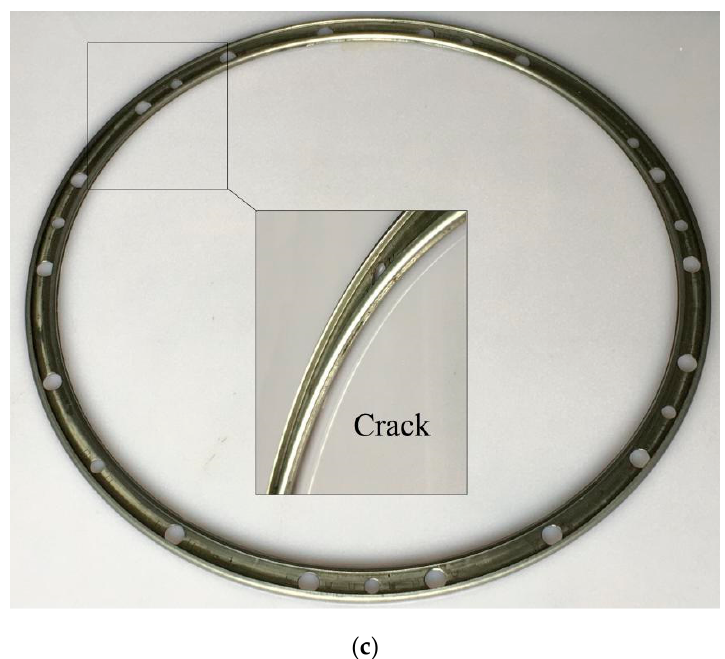
Figure 15. Defects of the concave ring formed by multi-pass stamping. ( a ) Rupture; ( b ) depression; ( c ) crack.